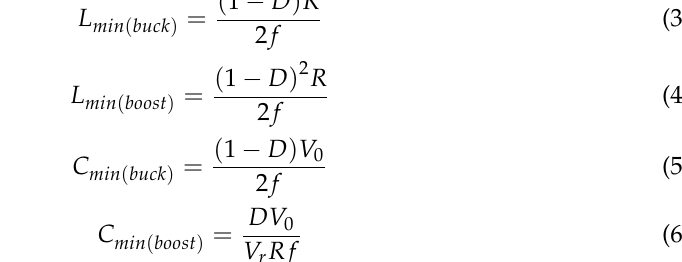
Table 2. Design specification of the proposed buck-boost converter.